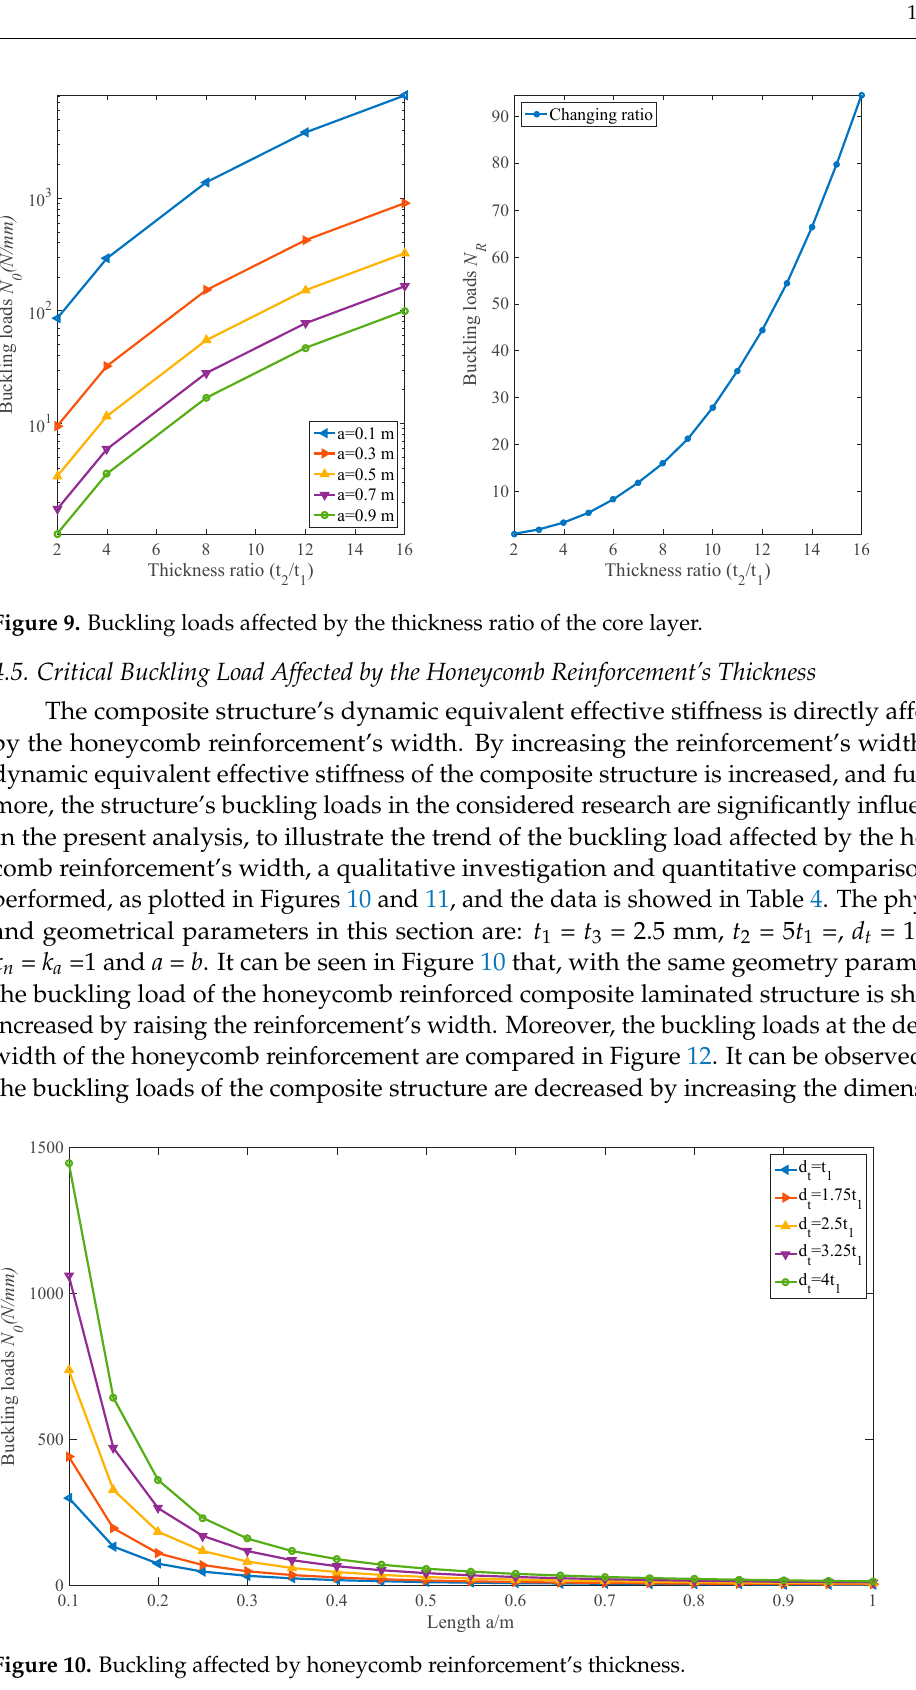
Figure 8. Buckling loads affected by the thickness of the core layer.